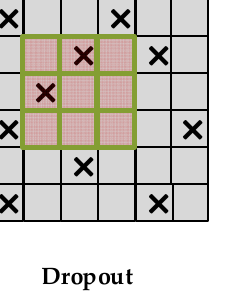
Figure 5. The difference between Dropout and Dropblock (Dropout omits multiple neurons randomly and Dropblock omits multiple neurons in continuous regions).